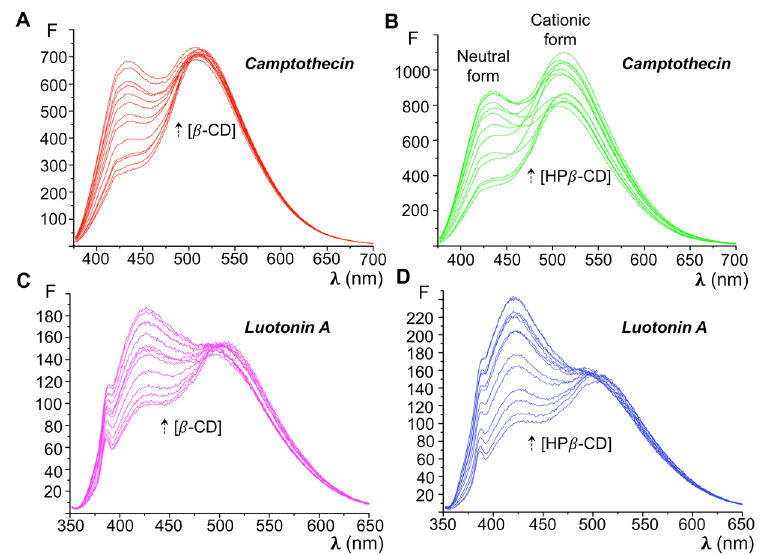
Figure 2. Initial studies that prove the formation in solution of inclusion complexes of camptothecin and luotonin A with β -CD and HP- β -CD. Fluorescence emission spectra of camptothecin in the pres- ence of: ( A ) increasing β -CD concentrations; ( B ) increasing HP- β -CD concentrations. Fluorescence emission spectra of luotonin A in the presence of: ( C ) increasing β -CD concentrations; ( D ) increasing HP- β -CD concentrations. The complexes were prepared in acidic